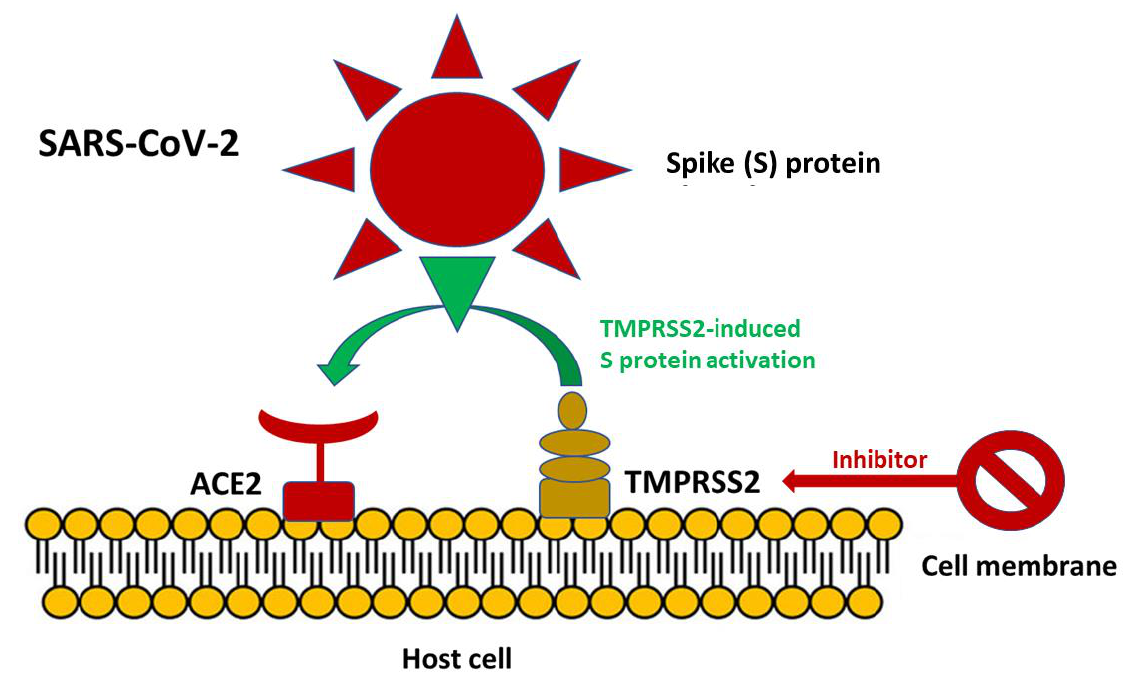
Figure 5. SARS-CoV-2 entry into ACE2 is facilitated by TMPRSS2 induced activation of the S protein via its serine protease activity. Inhibition of TMPRSS2 may furnish an alternative strategy to treat SARS-CoV-2 infection by blocking viral entry into host cells.